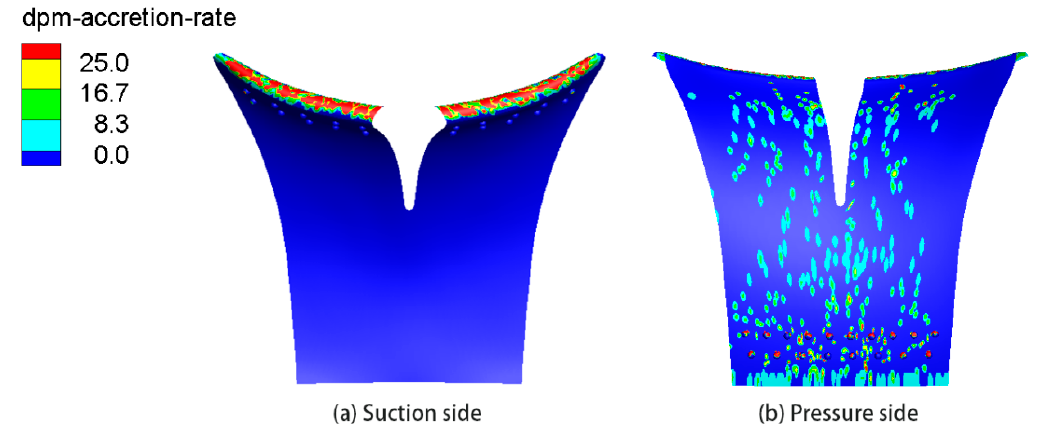
Figure 26. Accretion rate on the blade surface with bionic convex domes (units: kg/s).